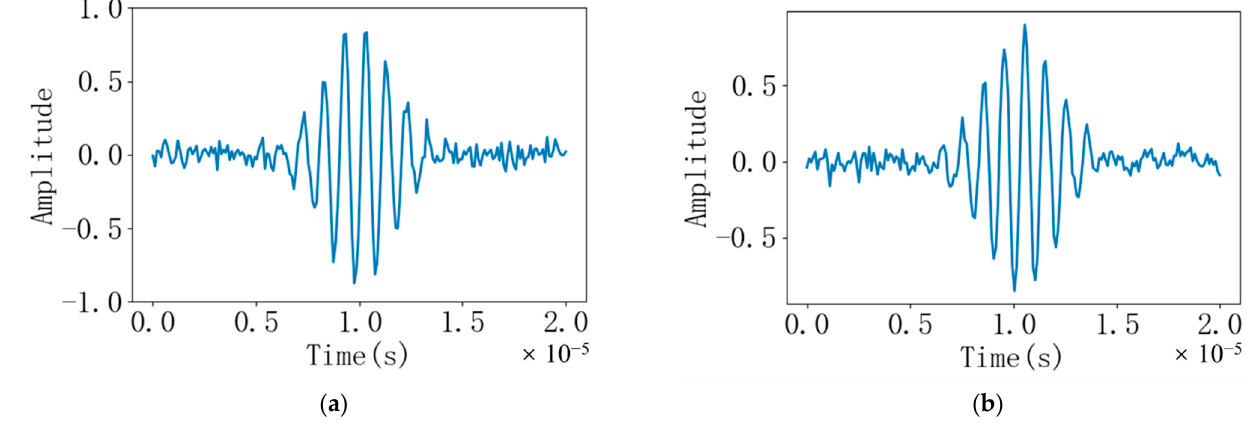
Figure 6. ( a ) Downstream echo signal with noise added; ( b ) Countercurrent echo signal with noise added.